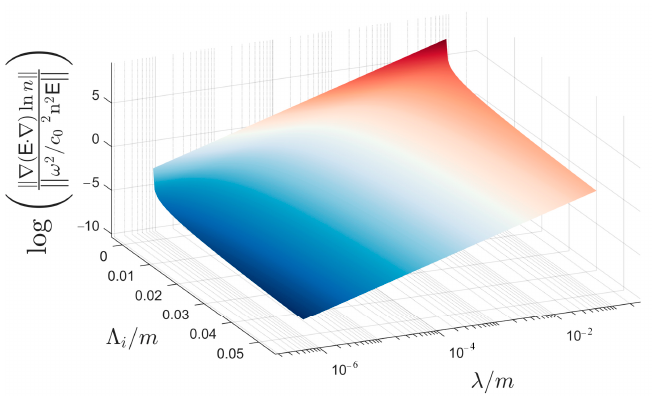
Figure 2. Variation trend in the ratio of the two terms in Equation (2) with wavelength and inner size.